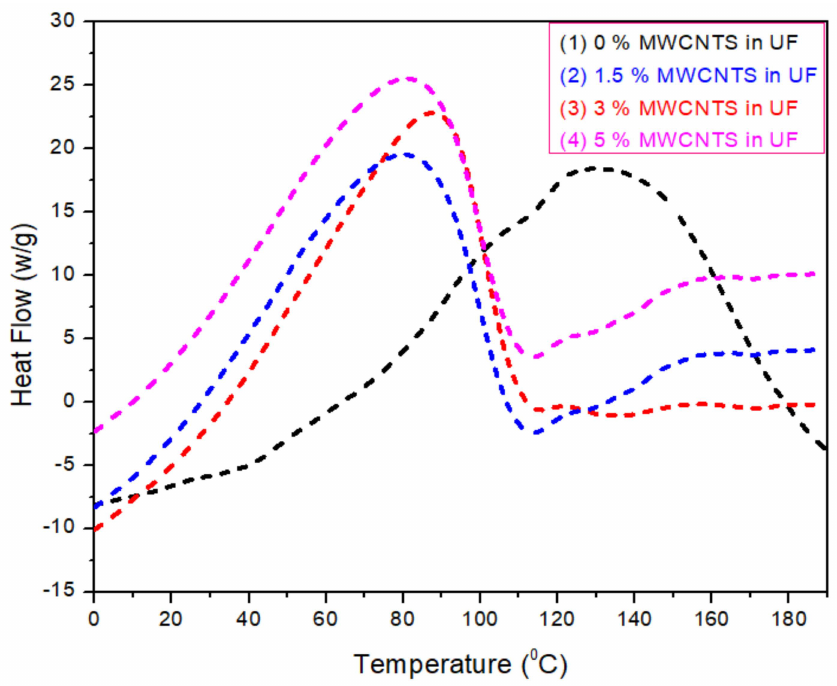
Figure 4. Differential scanning calorimetry of 0%, 5.0%, 1.5%, 3.0% and 5.0% MWCNTs in urea- formaldehyde resin.